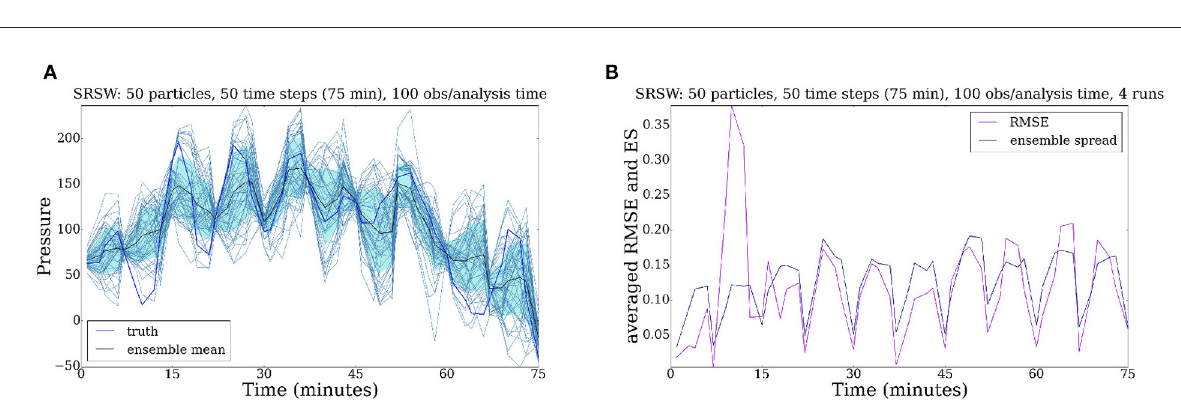
assimilate 100 observations without filter degeneracy.